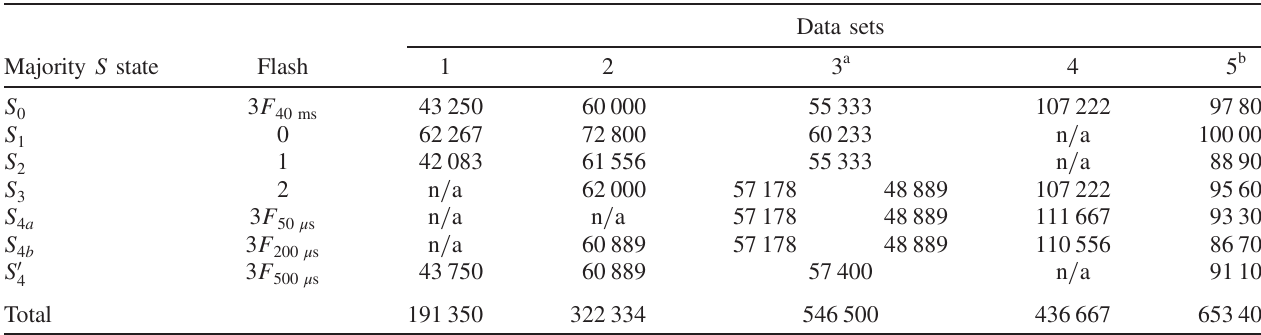
TABLE II. Approximate number of x-ray pulses per state, per beam